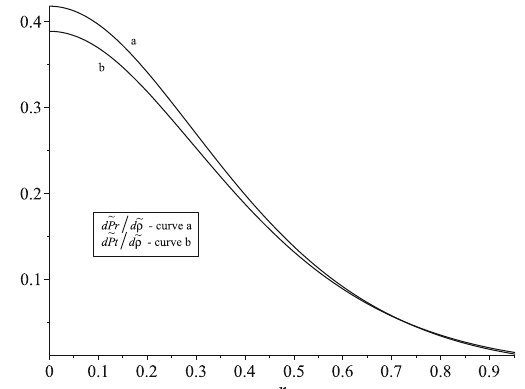
Fig. 24 Causality condition for the solution obtained with the second algorithm with ˜ F (cid:9)= 0 form the isotropic Gold III